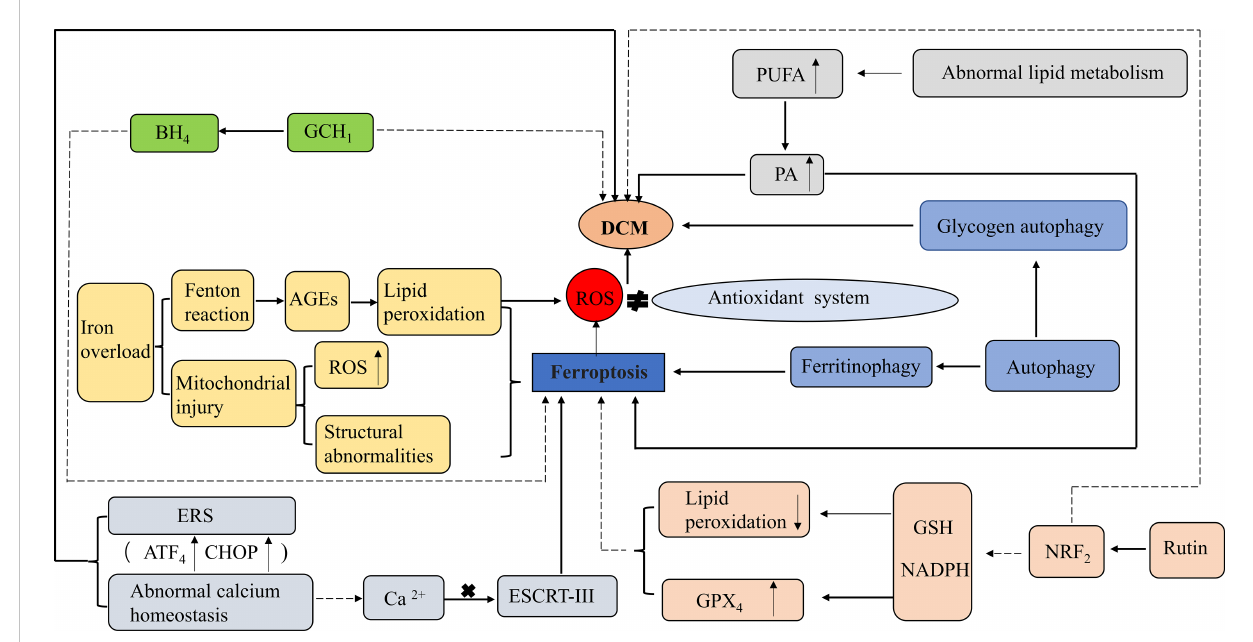
FIGURE 3 Role of ferroptosis in DCM. ROS, Reactive oxygen species;GPX 4 , Glutathione peroxidase 4; GSH, Glutathione; NADPH, Nicotinamide adenine dinucleotide phosphate; NRF 2 , nuclear factor-erythroid 2-related factor 2; PUFA, Polyunsaturated fatty acids; PA, palmitic acid; AGEs, Advanced glycation end-products; BH 4 , Tetrahydrobiopterin; GCH 1 GTP, (Guanosine triphosphate) cyclohydrolase 1; ERS, Endoplasmic reticulum stress; ESCRT-III, Endosomal sorting complexes required for transport III; ATF 4 , the activation of the transcription factor 4 (ATF4)- CCAAT-enhancer- binding protein (C/EBP) homologous protein (CHOP). Activation: Inhibition.